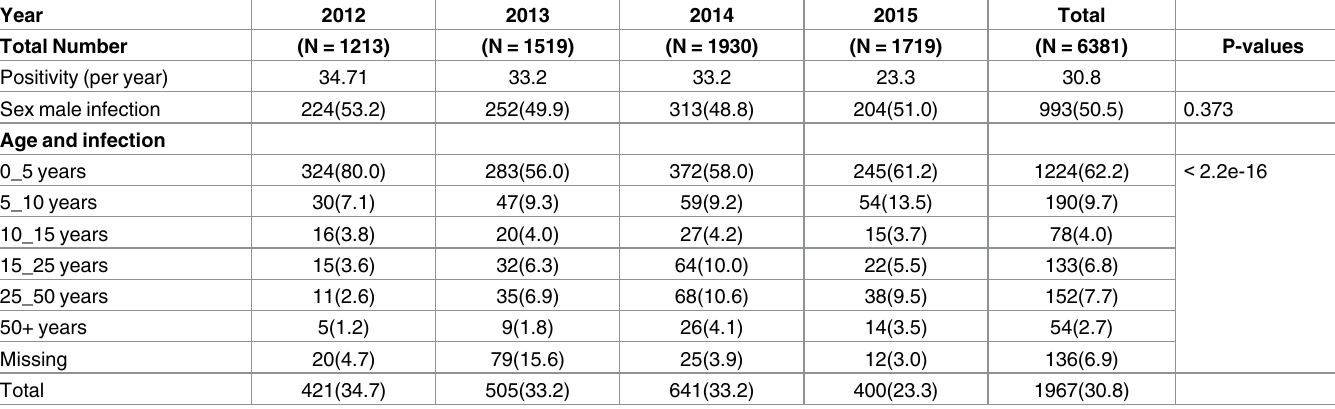
Table 2. Detection rates of human adenovirus infection in patients with ILI per year from 2012 to 2015 in Senegal and comparison of the distribu- tion into the different age